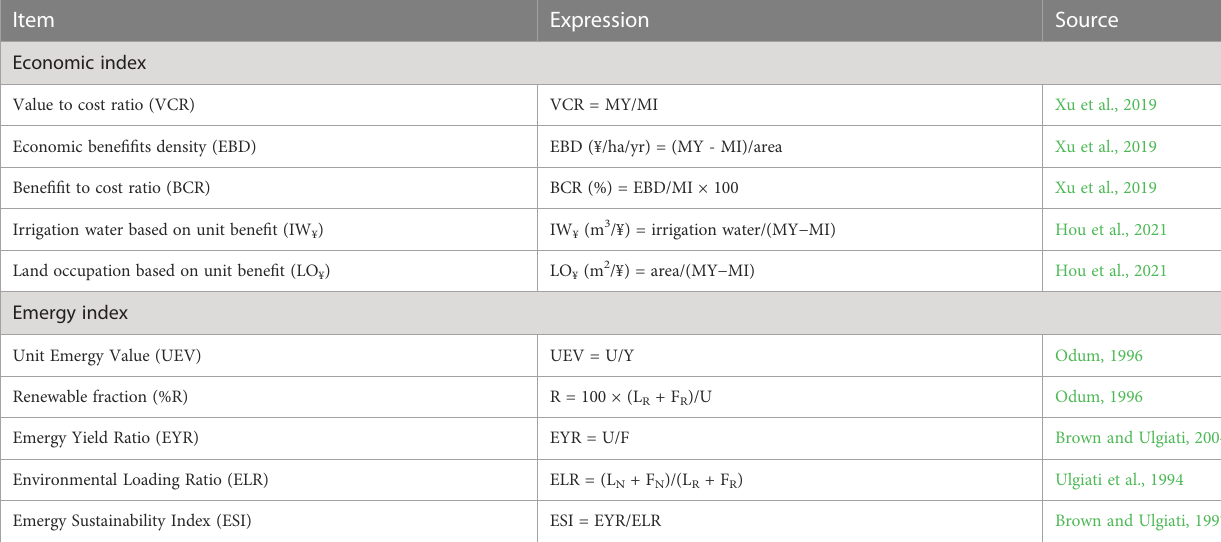
TABLE 2 Economic and emergy indices employed in this study and their expressions.